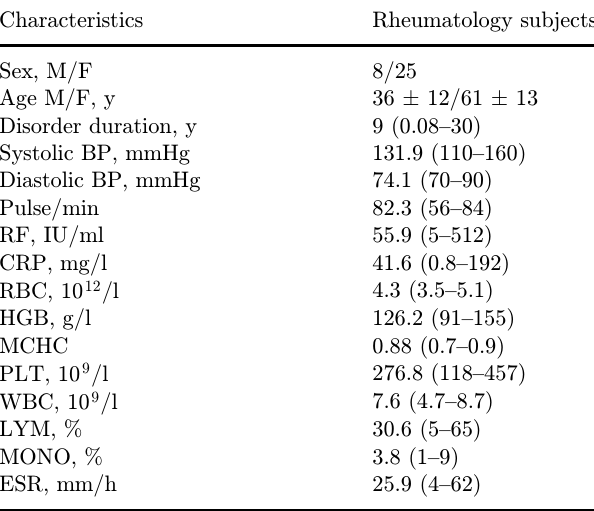
Table 1. The main characteristics of the patient group. Characteristics Rheumatology